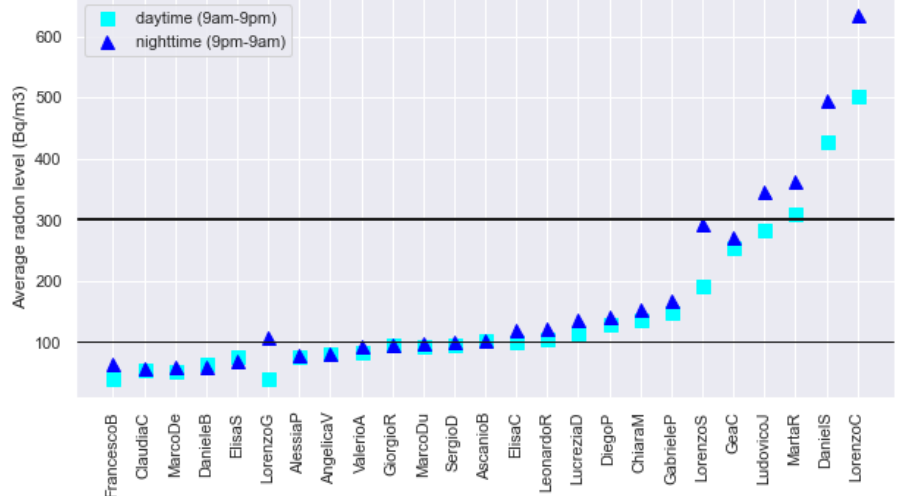
Figure 4. Average radon concentration computed during daytime (light blue squares) and nighttime (blue triangles) in the 25 apartments of Experiment 1. The EURATOM — recommended threshold of 300 Bq/m 3 and the WHO — recommended threshold of 100 Bq/m 3 are indicated as thick black, and thin lines, respectively.